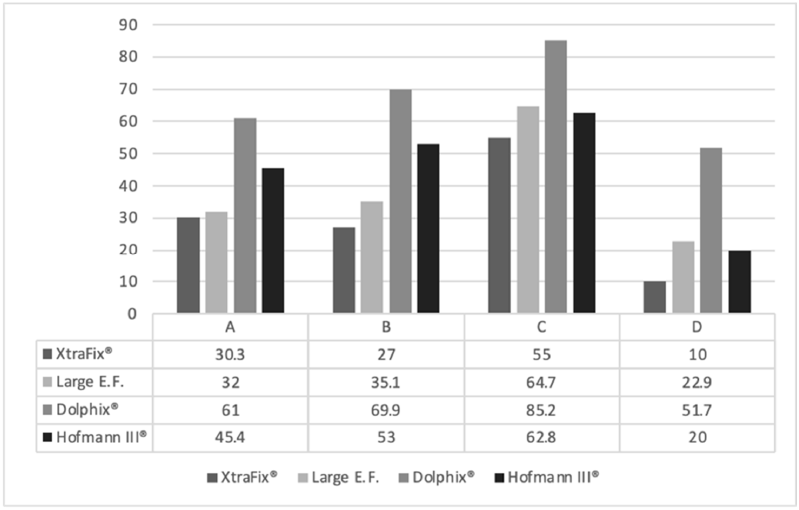
Figure 4. Plot describing the length of the areas free of distortion in mm calculating from the joint line in the four legs (A, B, C and D) instrumented with the devices XtraFix ® , Large E.F. ® , Dolphix ® and Hofmann III ®